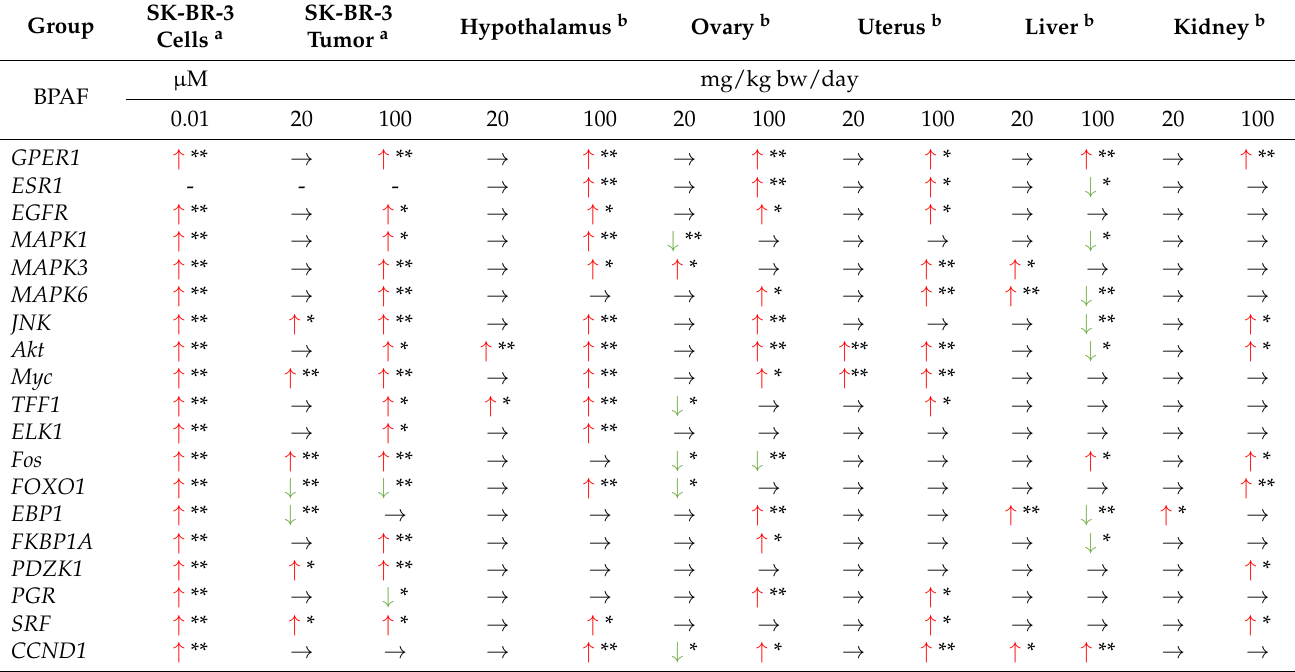
Table 1. The summary of mRNA levels of tested genes associated with GPER1-mediated PI3K/Akt and MAPK signaling pathways in SK-BR-3 cells or in various tissues from nude mice with SK-BR-3 xenograft